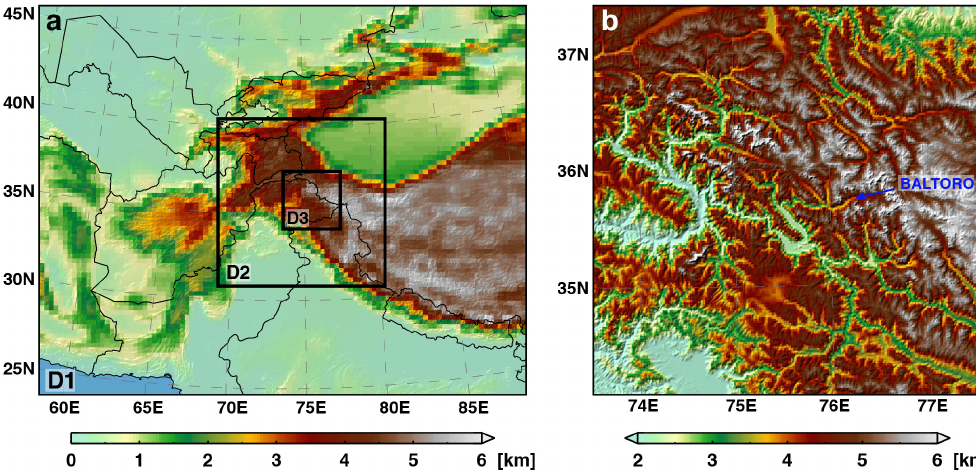
Figure 1. Topographic height shaded in units of km for (a) all three model domains in WRF-CMB, which are centered over the Karakoram and configured with grid spacings of 30, 10 and 2km, and (b) a zoom-in of the finest resolution domain, WRF